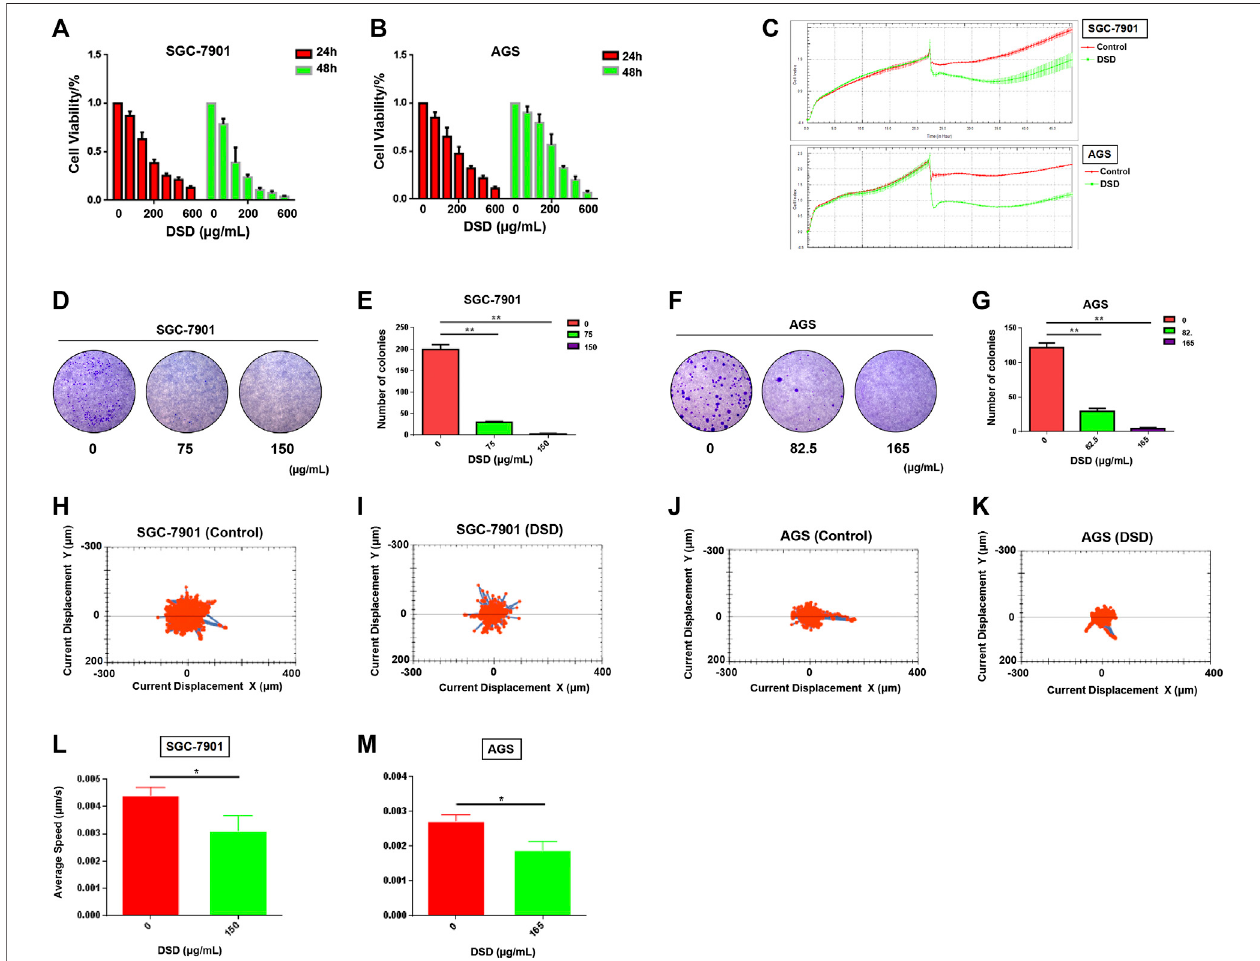
FIGURE 5 | DSD inhibited GC cell proliferation and decreased its viability. (A,B) CCK-8 assay was performed to measure cell proliferation rate at 24 and 48 h after DSDtreatmentatdifferentdosages(0,50,100,200,300,400,600 μ g/ml). (C) xCELLigenceRTCAwasusedtoevaluatethedrugtoxicityat24 hafterDSDtreatmentat 150 μ g/ml in SGC-7901 and 165 μ g/ml in AGS. (D – G) Cell colony formation assay was performed to measure cell clonality after DSD treatment for 24 h. ** p < 0.01 based on the Student t -test. (H – M) The Operetta CLS High Content Analysis System was used to evaluate the accumulated distance of cells at 24 h after DSD treatment at 150 μ g/ml in SGC-7901 and 165 μ g/ml in AGS.* p < 0.05 based on the Student t